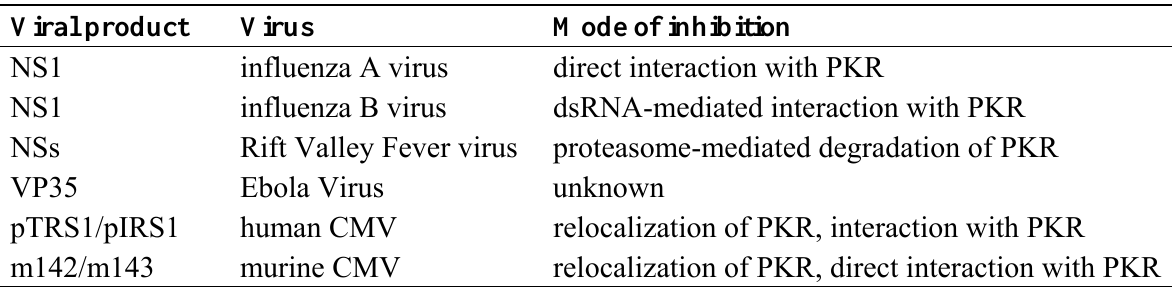
Table 2. Discussed viral gene products that inhibit PKR